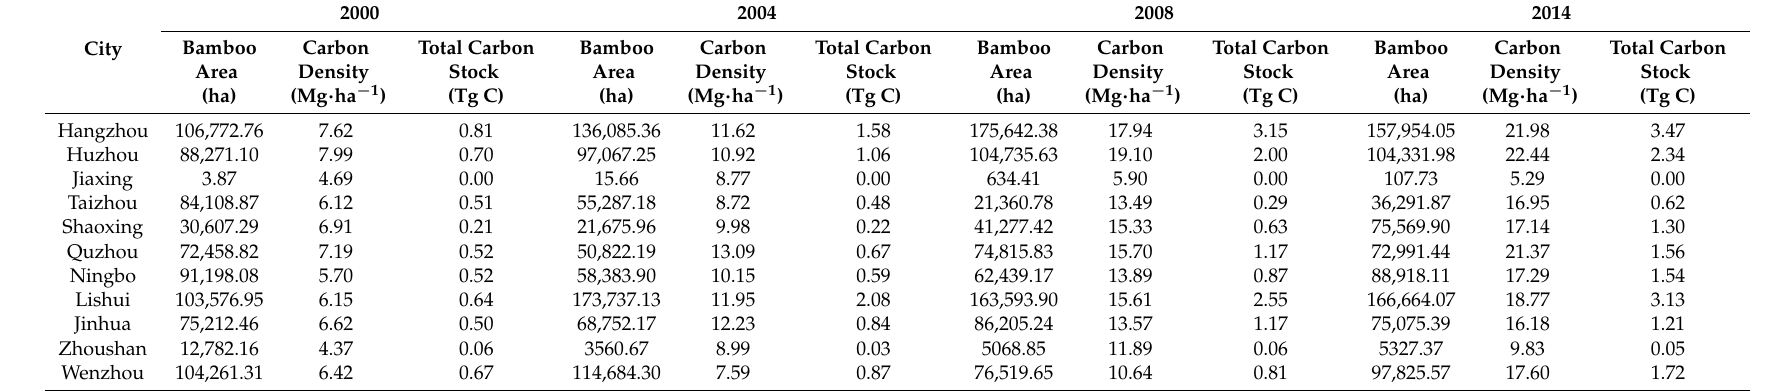
Table 4. The Spatial and Temporal Changes of Aboveground Carbon Storage in Bamboo Forest from 2000 to 2014 in Zhejiang